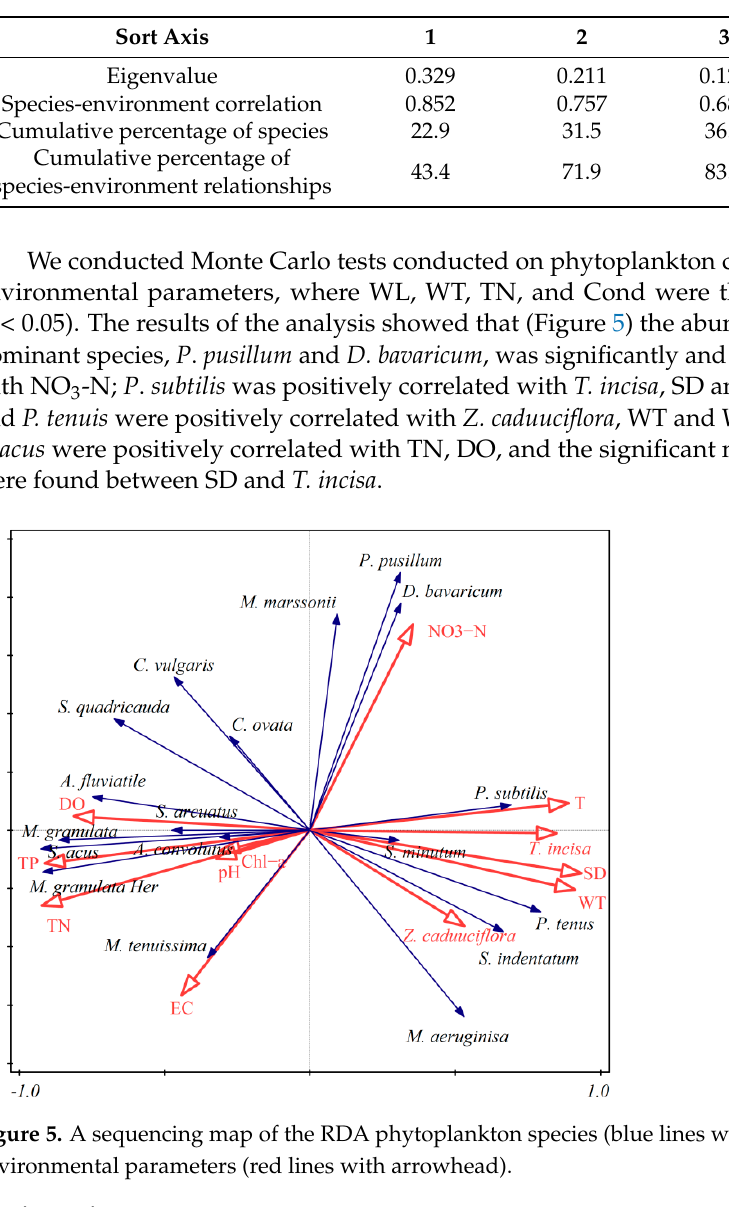
Table 3. Results of RDA analysis of dominant phytoplankton species.